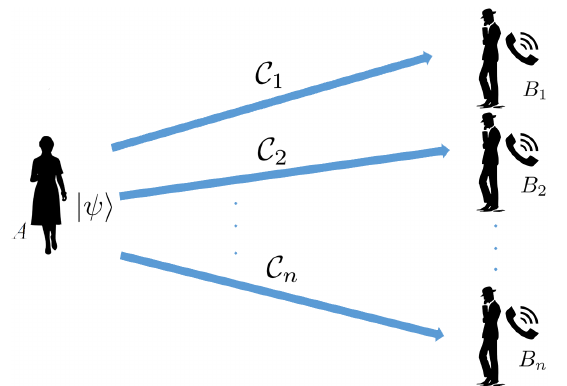
FIG. 1. Random-receiver quantum communication. The sender A wants to transmit a quantum message to one of n . The identity of the designated receiver B x is receivers ( B i ) n i = 1